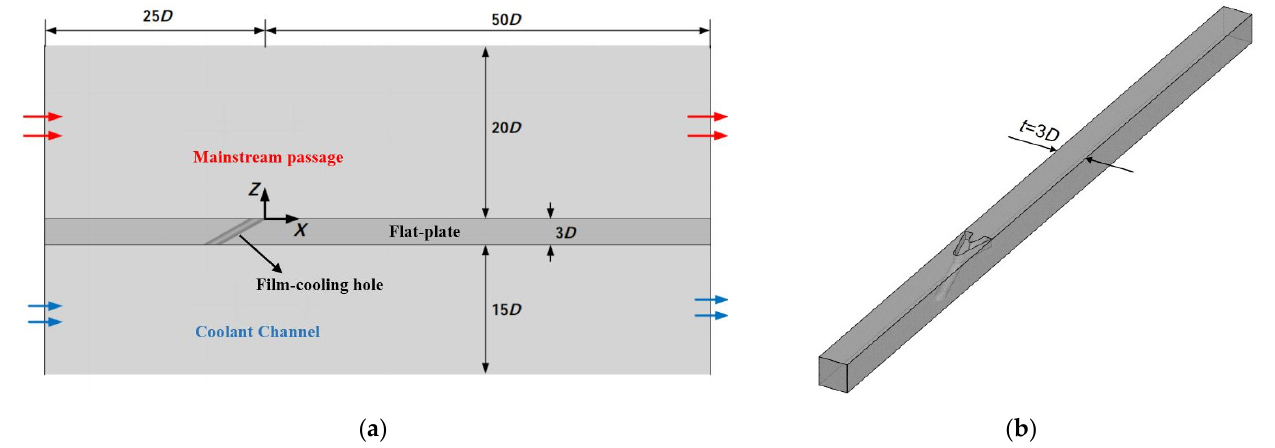
Figure 2. Computational model. ( a ) cross-section view; ( b ) solid domain for CRA2 model